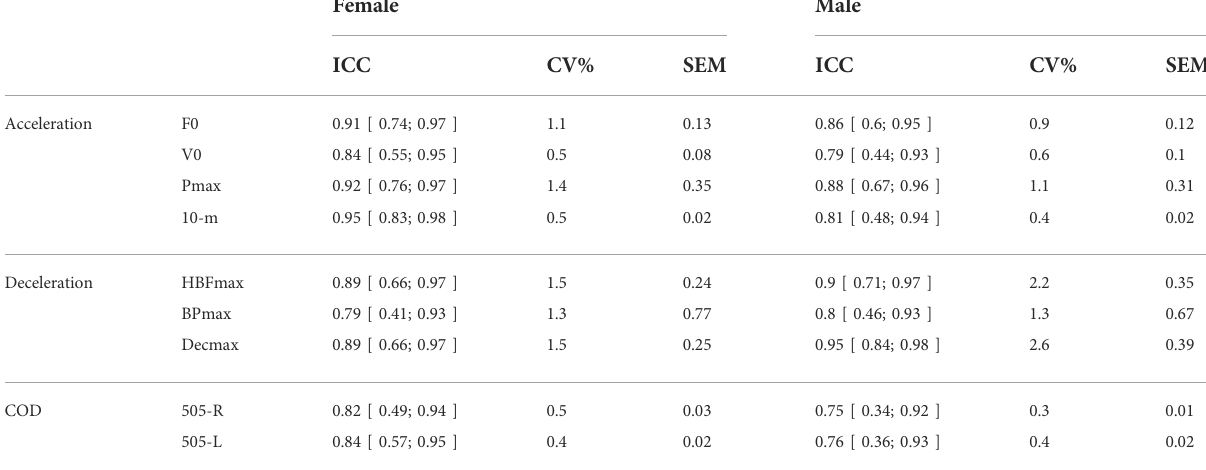
TABLE1IntraCoef fi cientCorrelation(ICC)fortheCODperformance,10-msprinttime,andmechanicalparametersofaccelerationanddeceleration. ICC = intraclass correlation coef fi cient; CV = coef fi cient of variation; SEM = standard error of the